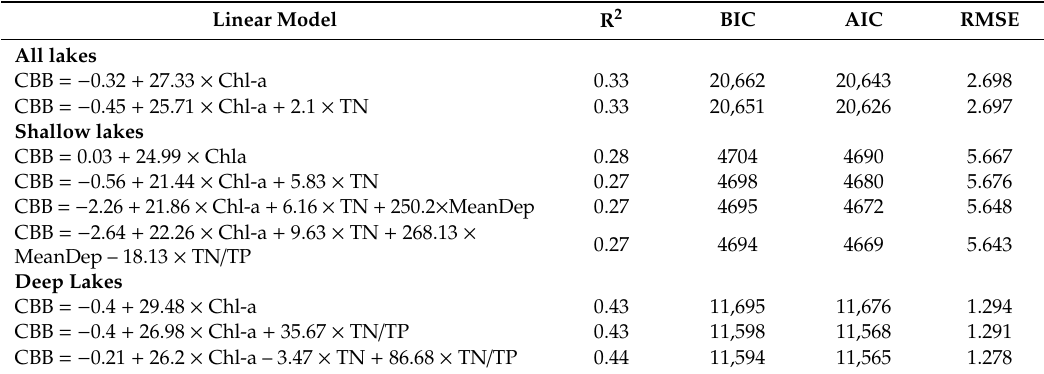
Table 4. Predictive linear models for